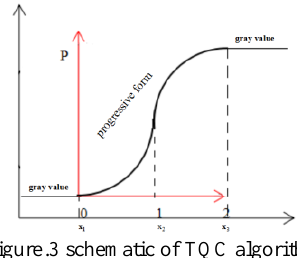
Figure.3 schematic of TQC